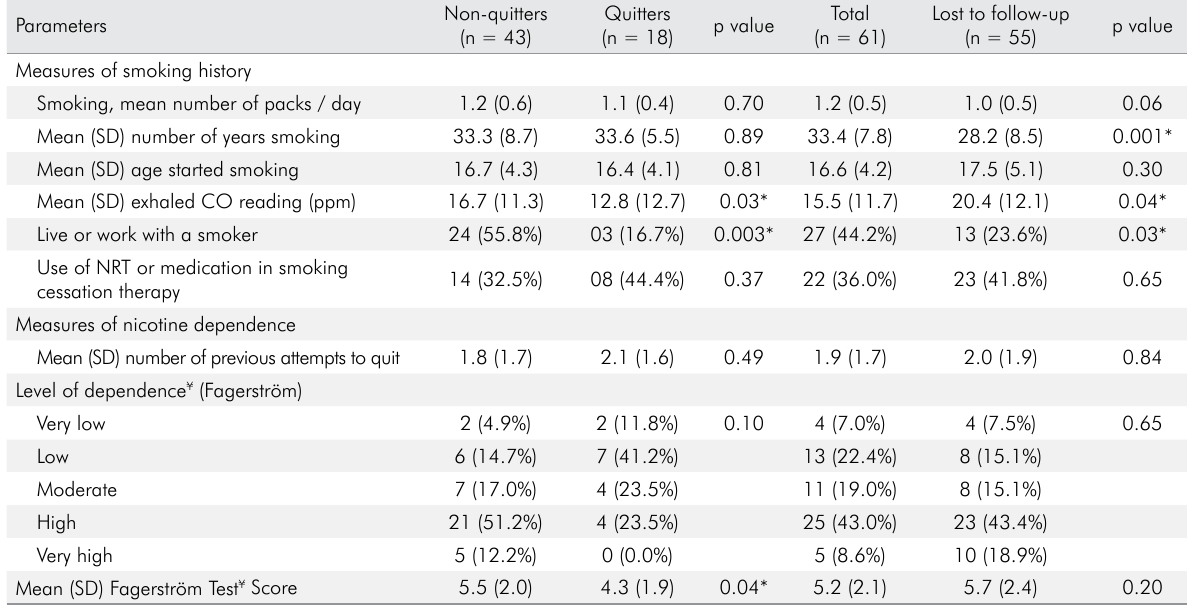
Table 2. Baseline smoking characteristics of non-quitters (smokers and oscillators combined) (n = 43), quitters (n = 18) and subjects lost after 2 years of follow-up (n =